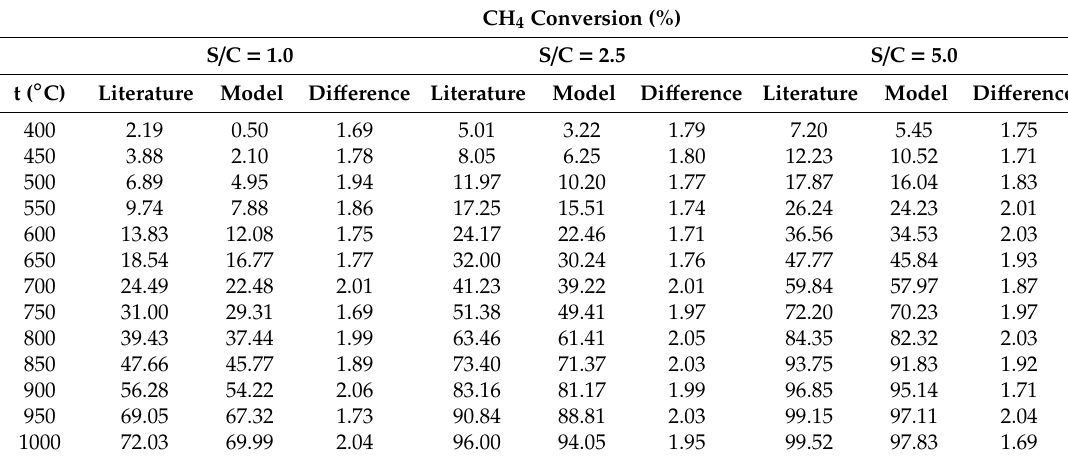
Table 4. Comparison between model and literature data for methane conversion at di ff erent steam-to-carbon ratios and temperature range from 400 to 1000 ◦ C at 20 bar [8,11,27]. CH 4 Conversion (%) S / C = 1.0 S / C = 2.5 S / C =